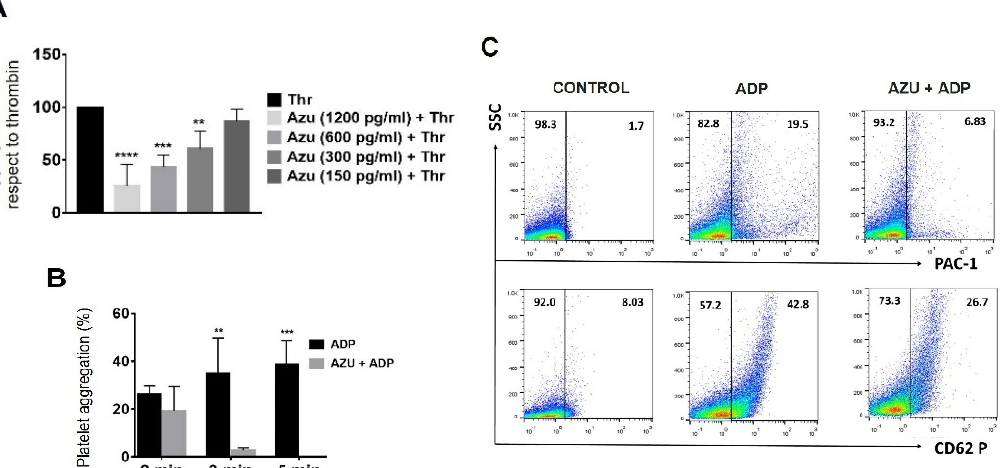
Figure 5. Inhibition of platelet aggregation and activation mediated by azurocidin. ( A ) Purified platelets were stimulated with 2 U of thrombin or pretreated (30 s before) with different concentrations of azurocidin, and platelet aggregation was subsequently evaluated. The figure shows the percentage of aggregation concerning thrombin treatment (100%). ( B ) The figure represents platelet aggregation over time of platelet-rich plasma (PRP) treated with 2 µM ADP or with the addition of 1200 pg/mL azurocidin. ( A , B ) represent the mean ± standard deviation of 4 independent experiments. Statistical significance was determined by a Dunnett’s ( A ) and Sidak’s ( B ) multiple comparison test, and is represented as ** p < 0.01, *** p < 0.001, **** p < 0.0001. ( C ) Representative dot plots of 3 independent experiments for surface expression of PAC-1 (upper) and CD62P (lower) in platelets that received the treatments indicated in the figure. The tests are the result of a previous selection of CD41 + platelets. 2.4. Azurocidin Inhibits Platelet Aggregation and Activation As mentioned earlier, some microbicidal molecules present in platelets can modulate platelet activation. For this reason, we evaluated the effect of azurocidin on this biological function. Our findings show that different concentrations of azurocidin (150–1200 pg/mL)